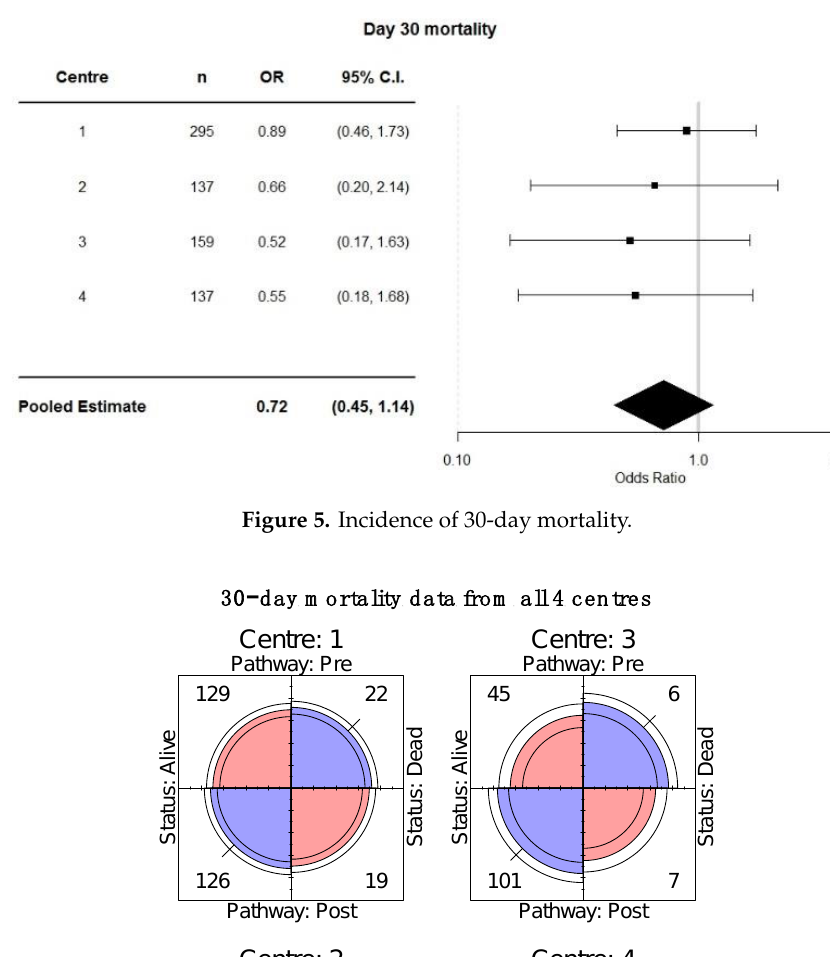
Figure 7. Cumulative 30-day mortality data. 4. Discussion Our results suggest that the implementation of a quality improvement care bundle, although conferring a survival benefit, does not affect the incidence of AKI in the immediate post-operative period or in the 30 days after surgery. This is true for both the individual institutions and the cumulative data from all four centres. Therefore, it is reasonable to conclude that the survival benefit seen in the original study is not related to a reduction in AKI, as defined by changes in serum creatinine. This is in keeping with studies on goal-directed therapy in surgery, where a benefit in terms of renal outcomes tends to be observed mainly where vasopressors are employed together with goal directed fluid therapy. The effects of goal-directed fluid therapy have been examined in major gastrointestinal surgery. The OPTIMISE trial randomised 734 high risk patients across 17 UK centres